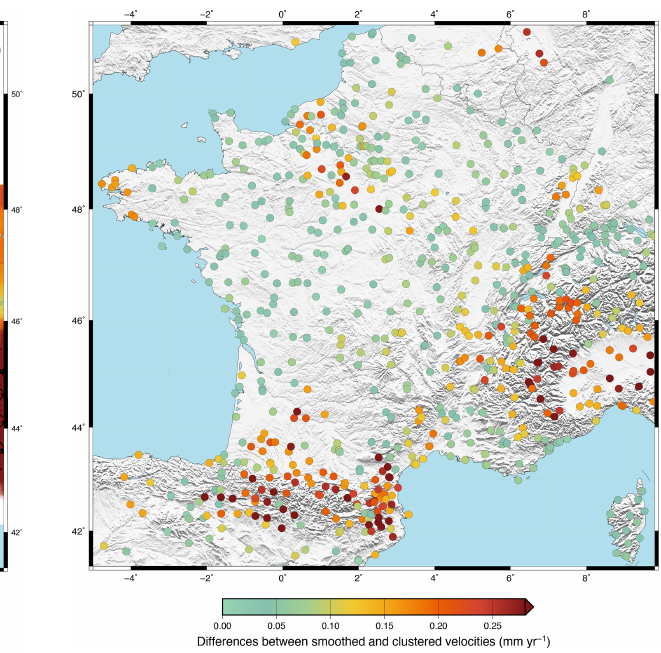
Figure 8. Map of the differences between the velocities obtained from the clustering and from the Gaussian smoothing